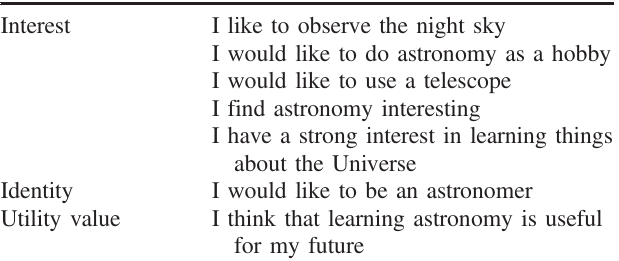
TABLE II. Items used to measure interest towards astronomy, astronomy identity, and astronomy utility